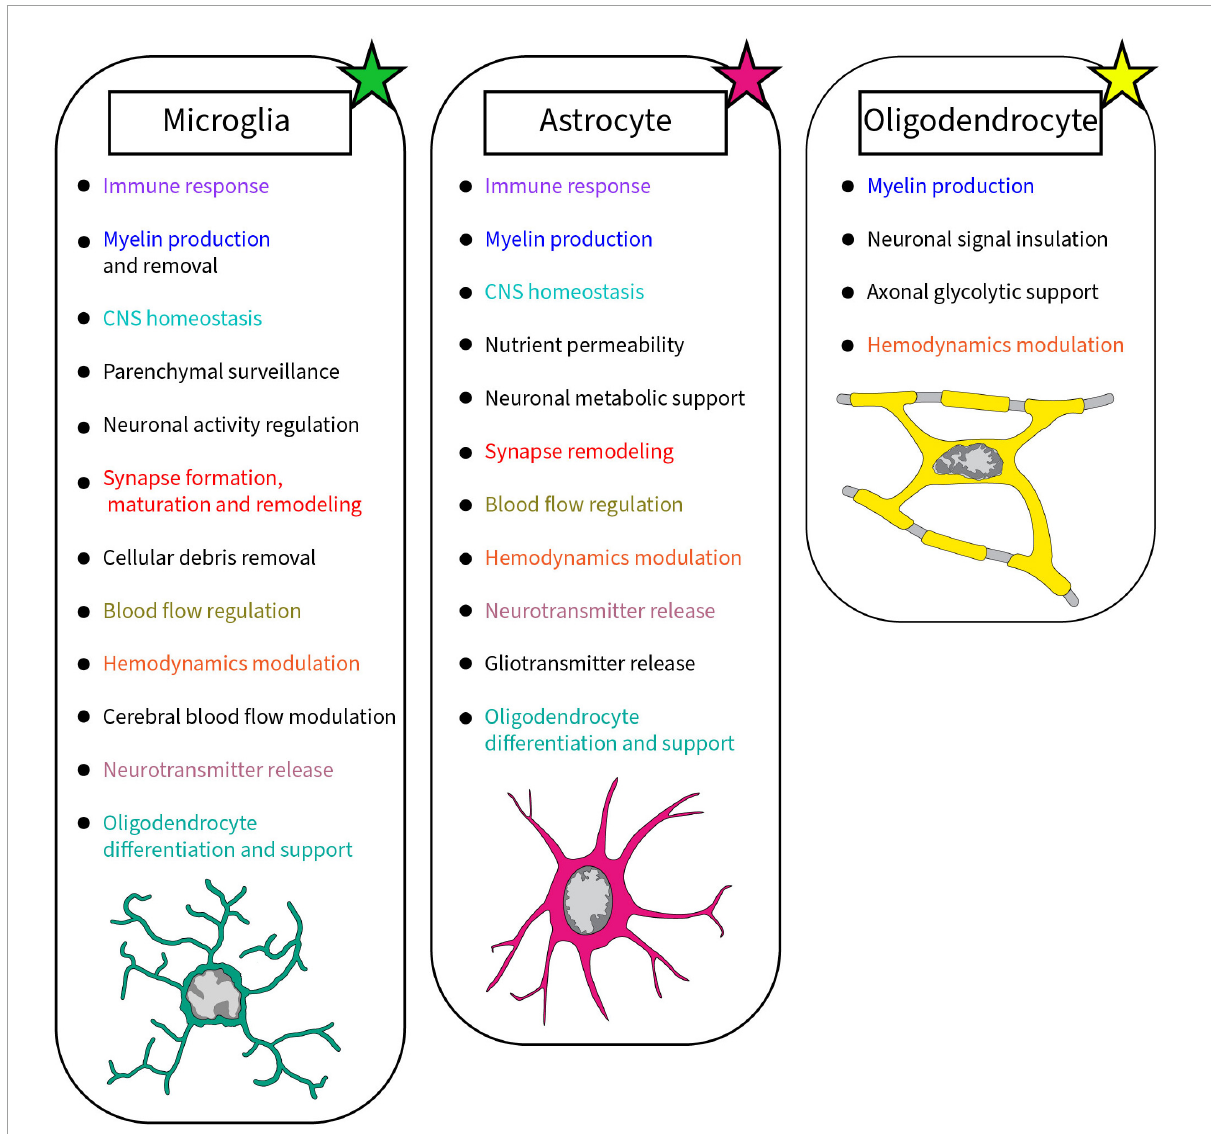
FIGURE1 Summary of the roles accomplished by glial cells in the brain discussed in this review. Each glial cell, microglia, astrocyte, and oligodendrocyte, achieves crucial roles in the healthy developing and mature brain. Colors were used to highlight the similar roles between glial